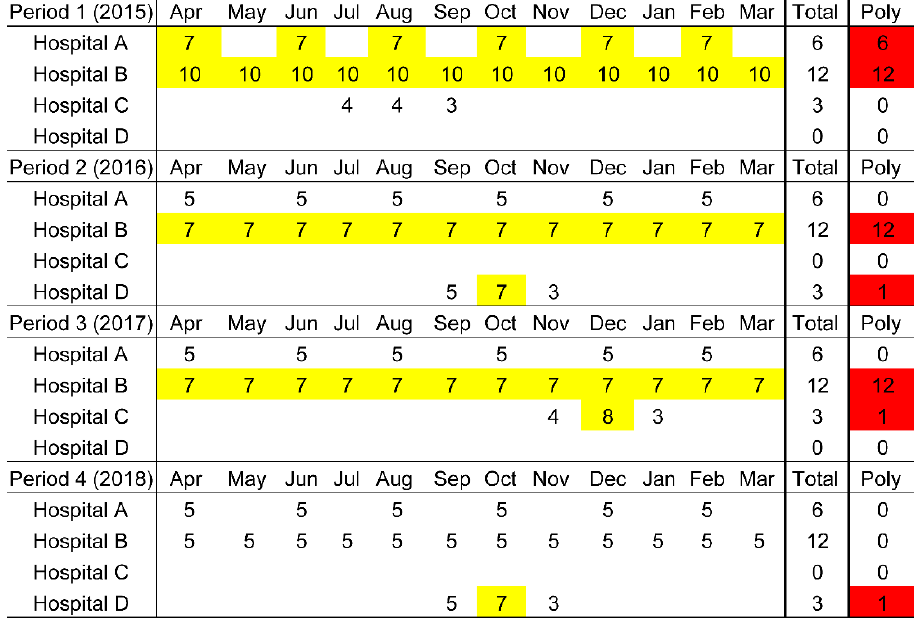
Figure 2. Case series example of total annual prescriptions and annual polypharmacy prescriptions during Periods 1 to 4.